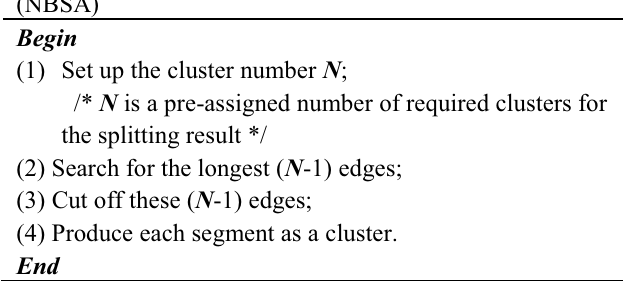
Algorithm-2 : The number-based splitting algorithm